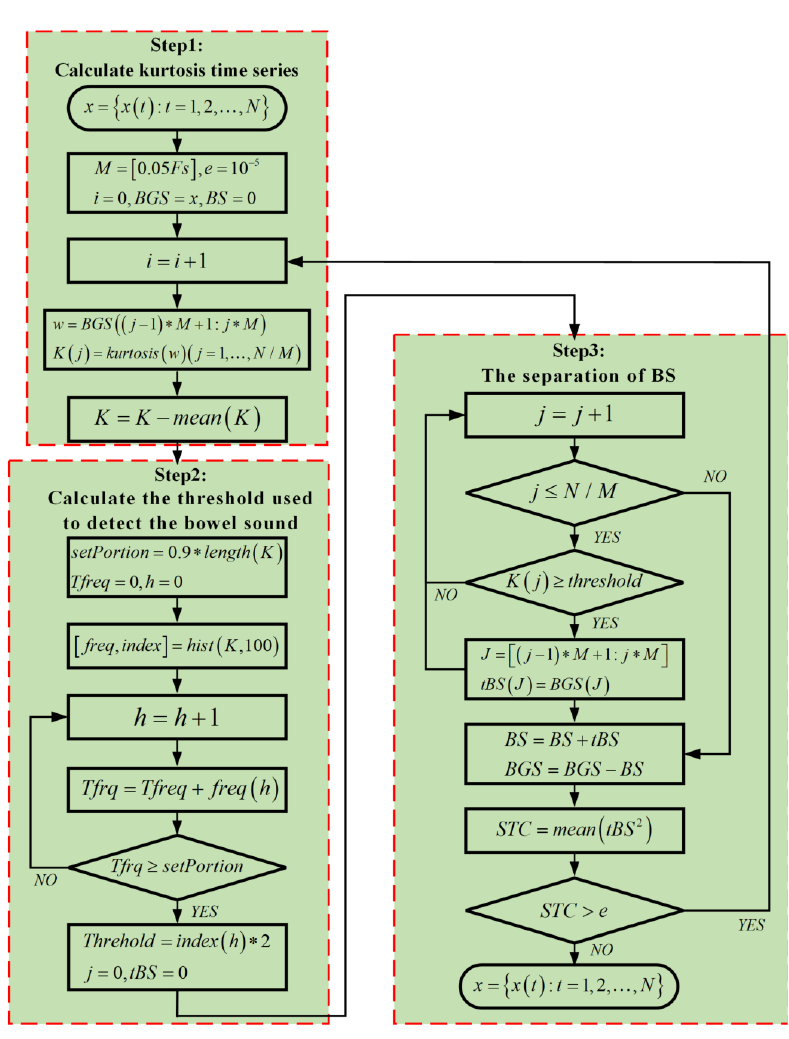
Figure 5. Flow chart of mIKD